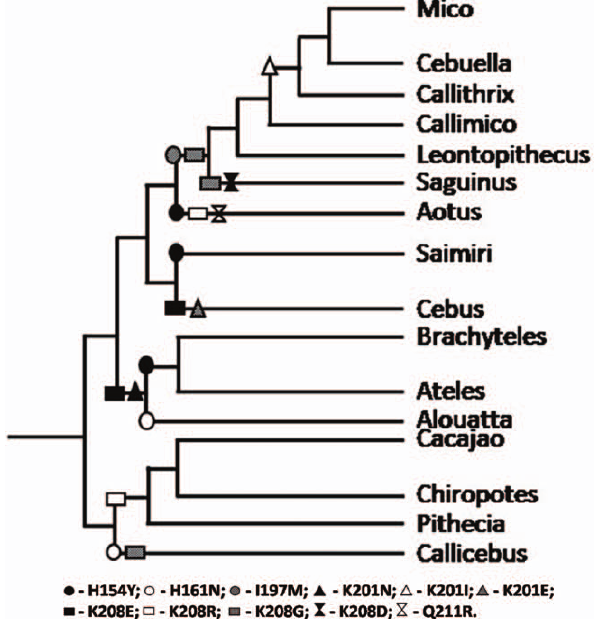
Figure 1. Representation of the likely emergence of a 4 amino acid substitutions encoded by ITGA4 exons 5 and 6 across neotropical primate radiation. The consensus amino acid sequence of the Platyrrhini group was used as the ancestral root of the tree, and residue replacements refer to that sequence. Each replacement had its emergence estimated and placed into the most updated Platyrrhini phylogeny according to Perelman et al . [29].